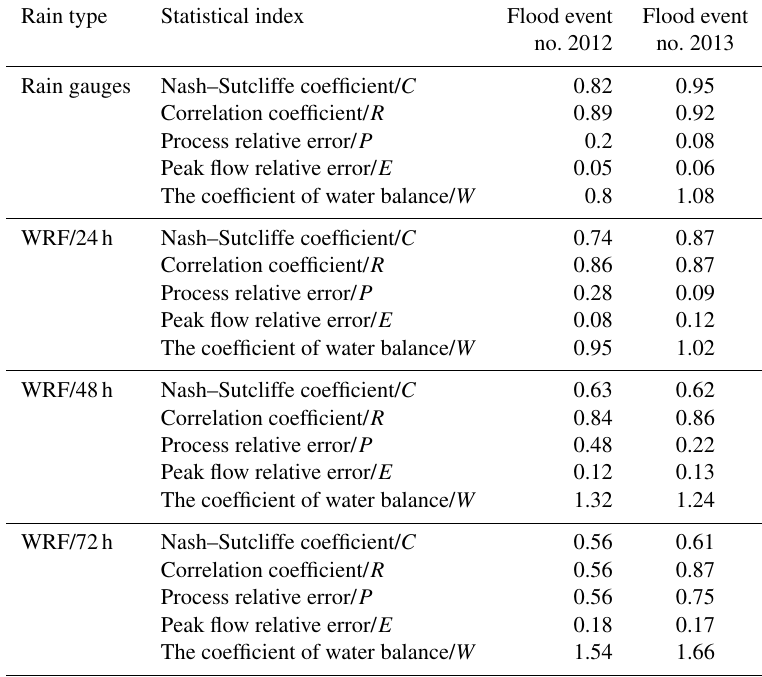
Table 4. Evaluation indices of the simulated flood event with different lead